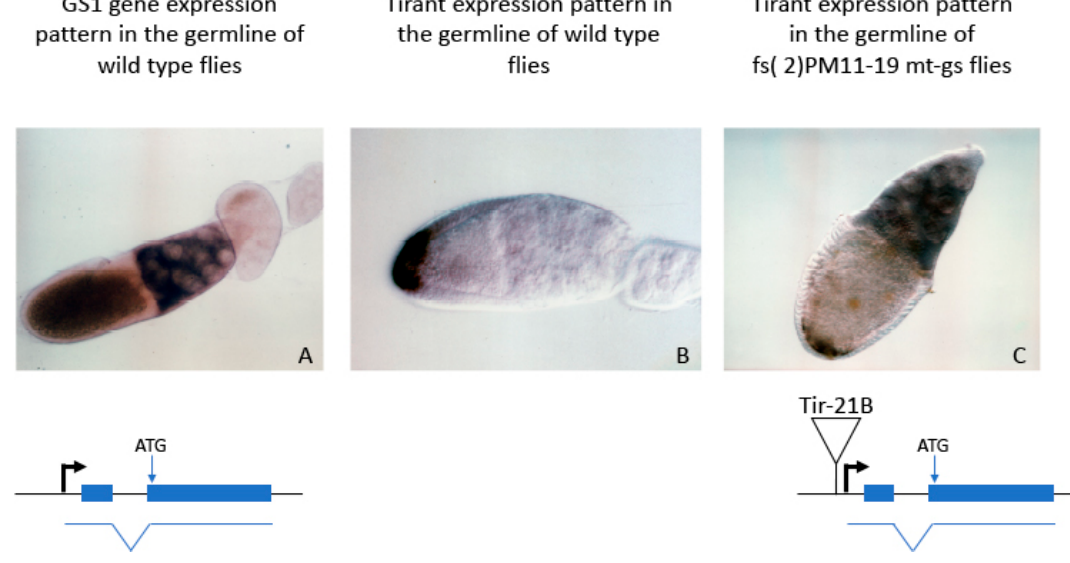
Figure 3. In situ hybridization performed on wild type (panels A and B ) or mutant (panel C ) ovaries using GS1 (panel A ) or Tirant (panels B and C ) specific probes. The organization of the relevant locus in the 21B region of the polytene chromosomes of D. melanogaster is provided.